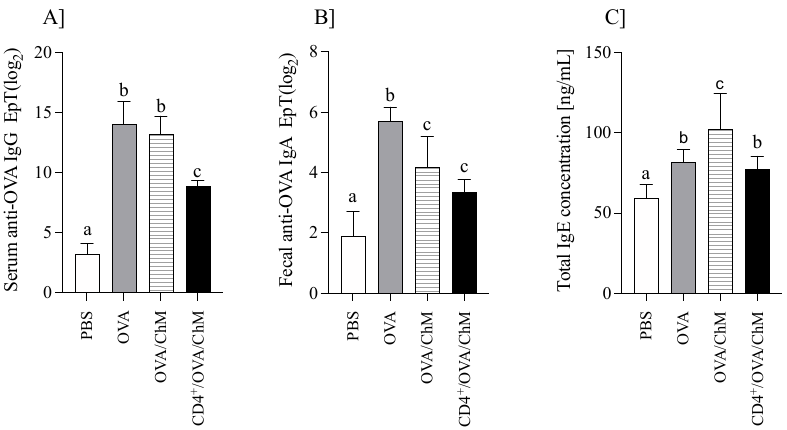
Figure 1. The humoral response in mice of PBS, OVA, OVA/ChM, and CD4 +/ OVA/ChM groups: ( A ) serum anti-OVA IgG; ( B ) fecal anti-OVA IgA; ( C ) total serum IgE concentration. One-way ANOVA with a post hoc Tukey test and a Kruskal–Wallis test was used to determine statistical differences. Bars represent the mean of the group ( n = 8) ± SD. a,b,c Mean values with different superscripts are different at p ≤ 0.05.